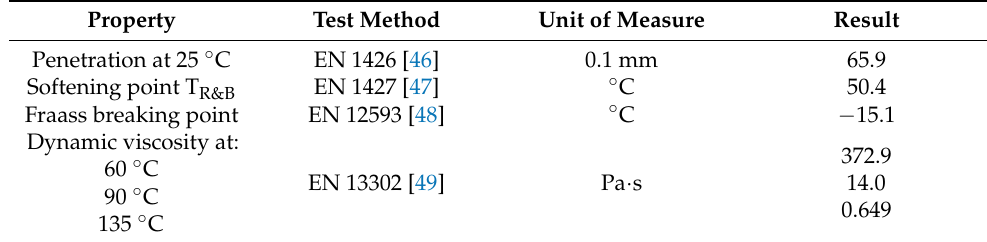
Table 1. Basic properties of 50/70 bitumen [36].